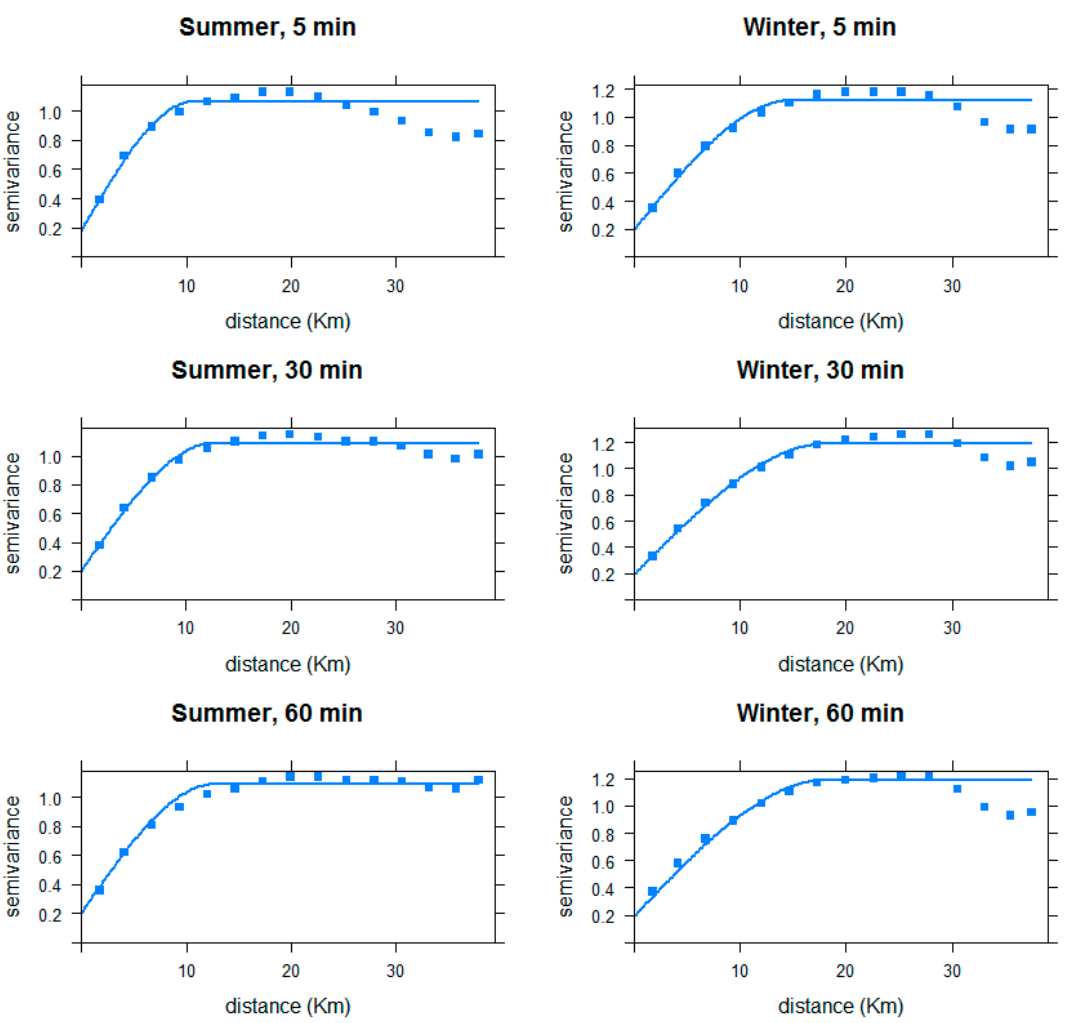
Figure 6. Selected experimental (points) and theoretical variograms (blue line) for the three temporal resolutions and both seasons.